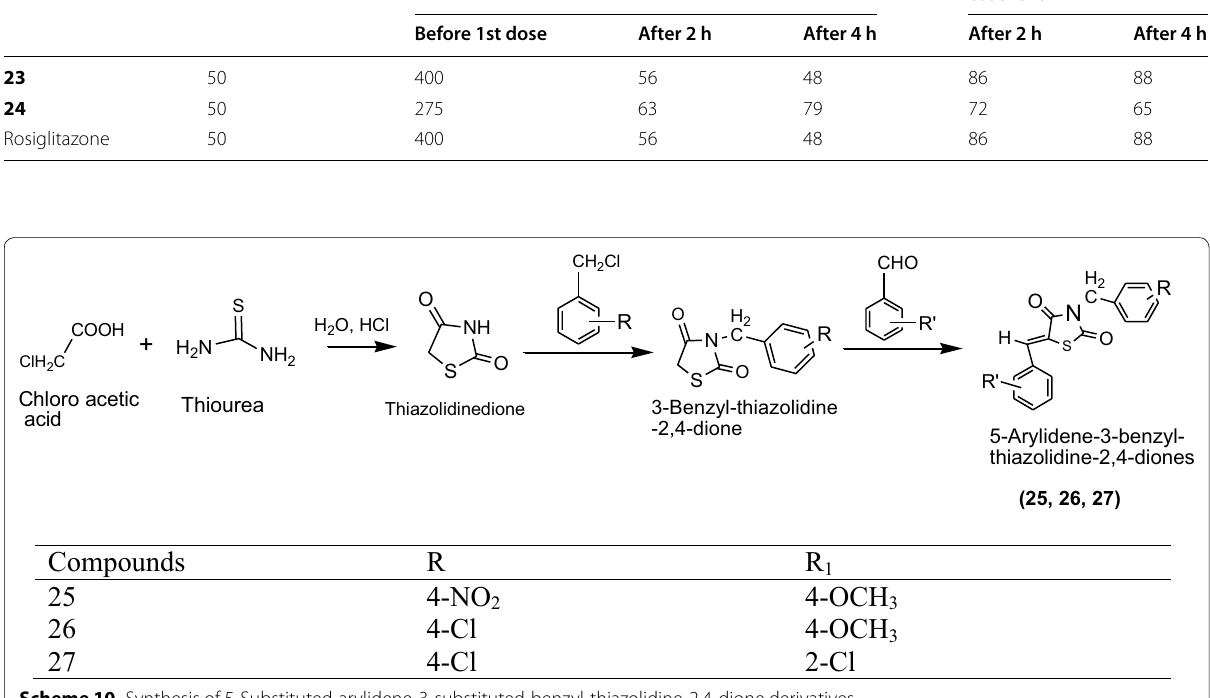
Table 10 Hypoglycemic activity of synthesized derivatives Treatment